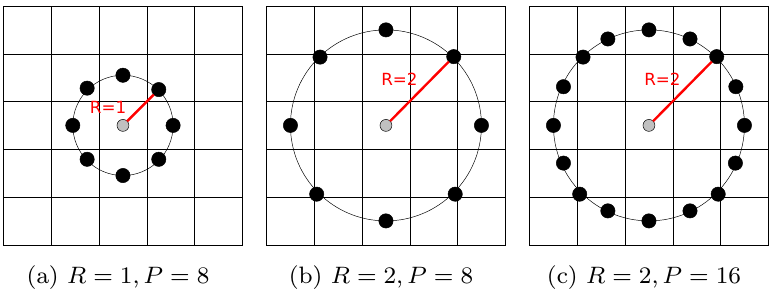
Figure 2. Circularly symmetric P neighbors extracted from a distance R